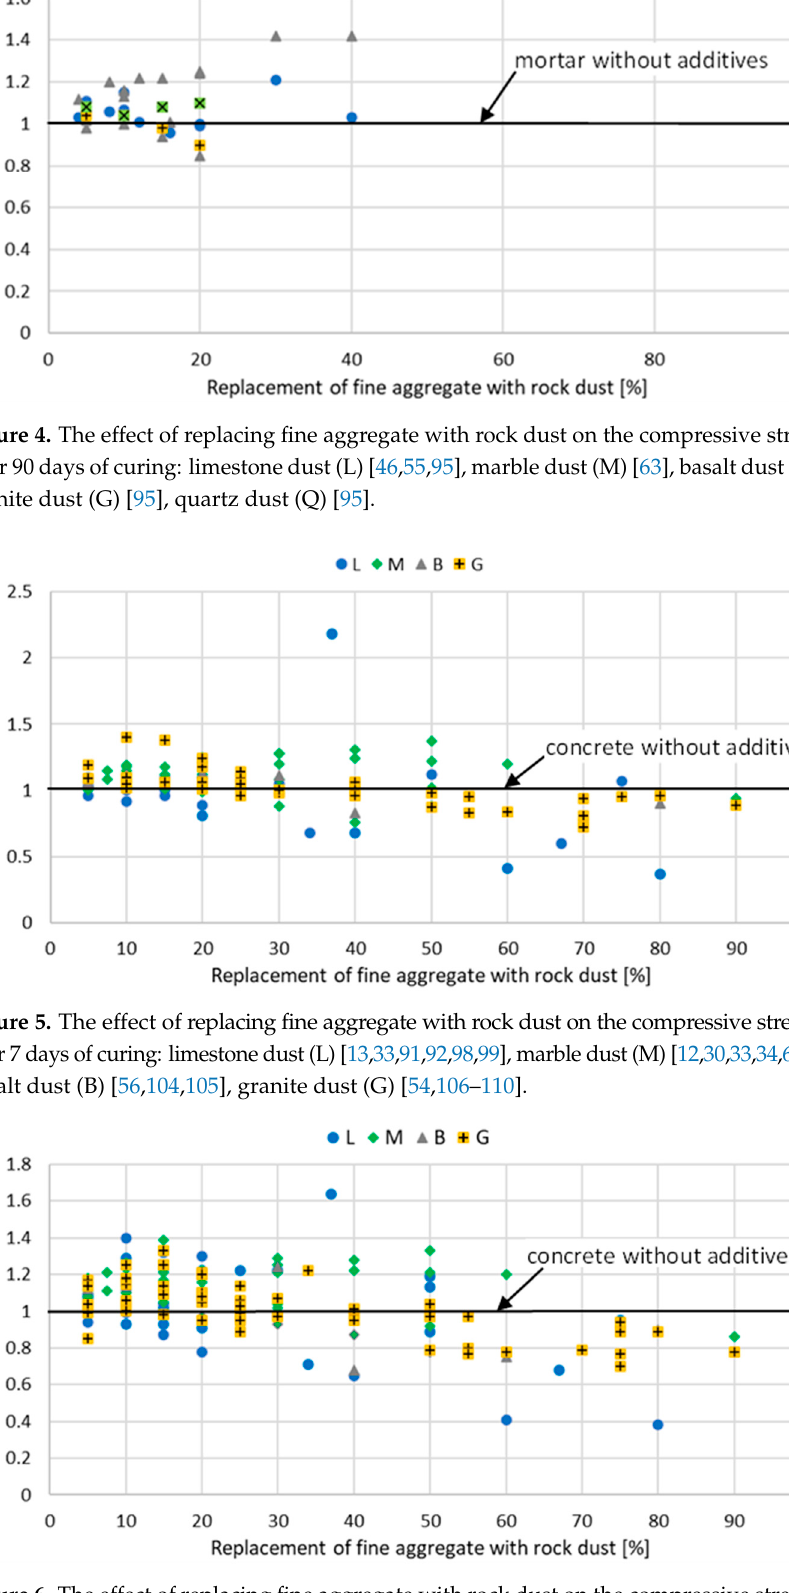
Figure 6. The effect of replacing fine aggregate with rock dust on the compressive strength of concrete after 28 days of curing: limestone dust (L) [13,22,33,44,91,92,98,99,111], marble dust (M) [12,30,33,34,61,93,94,100–103], basalt dust (B) [56,104,105], granite dust (G) [14,17,18,54,106–110].